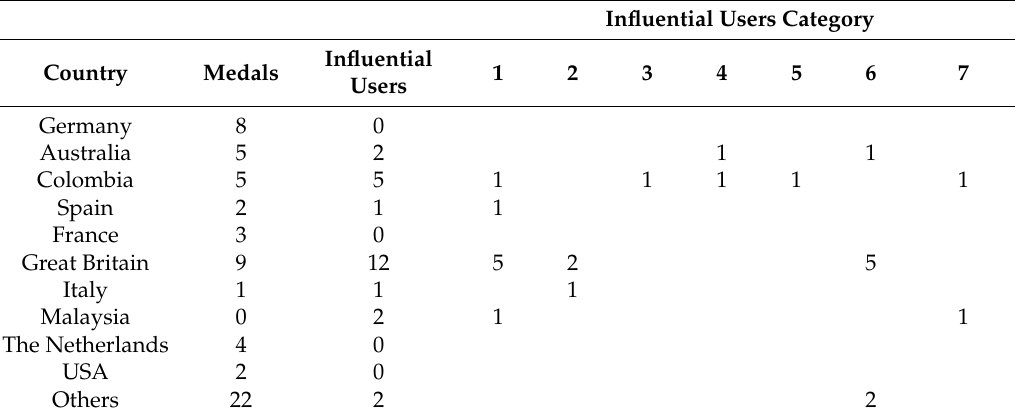
Table 8. Distribution of influential users by country and category. 2016